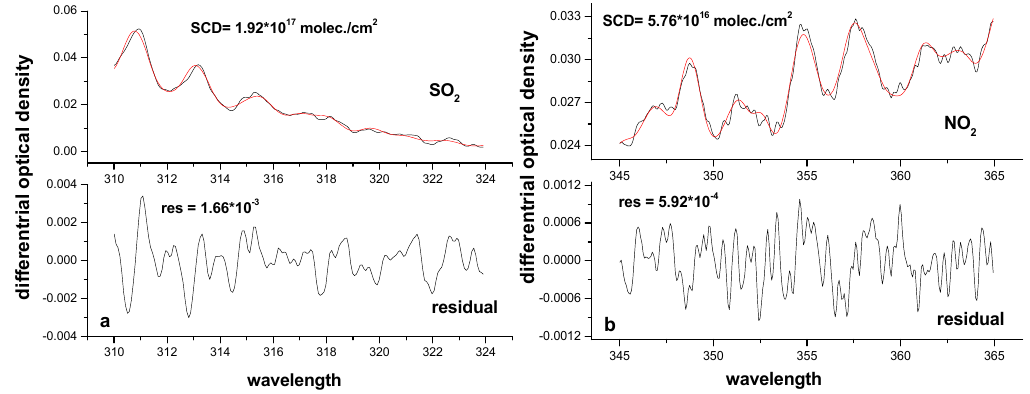
Figure 3. SO 2 and NO 2 fitting. The spectra are recorded at the time of 12:35:02 on 16 October 2011. ( a ) SO 2 retrieval result, SO 2 SCD = 1.92 × 10 17 molec./cm 2 , SO 2 residual = 1.66 × 10 − 3 ; ( b ) NO 2 retrieval result, NO 2 SCD = 5.76 × 10 16 molec./cm 2 , NO 2 residual = 5.92 × 10 − 4 .